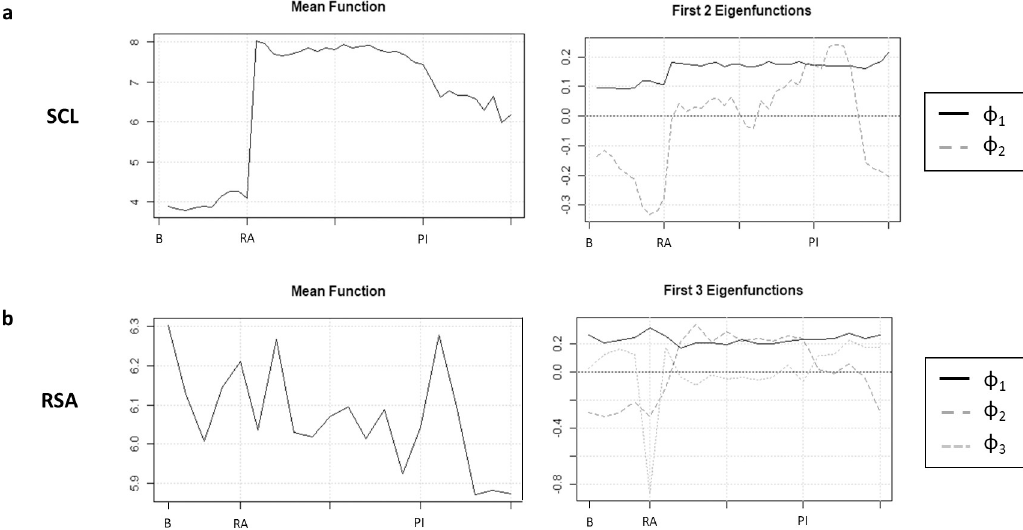
Fig 1. Mean functions and eigenfunctions for skin conductance and respiratory sinus arrythmia. The x-axis is time (in minutes). B = baseline; RA = roles assigned; PI = post-interaction.